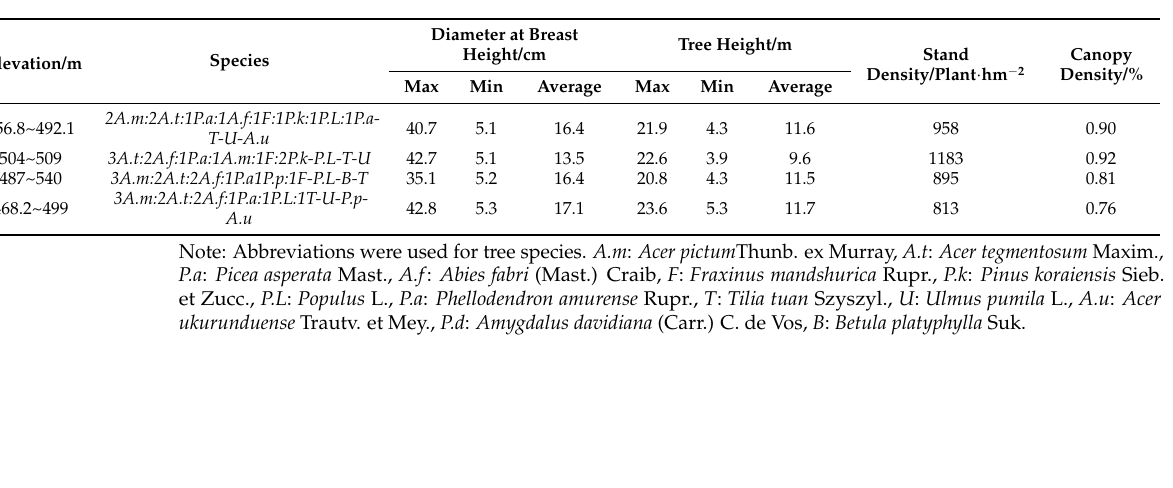
Table 1. General characteristics of the